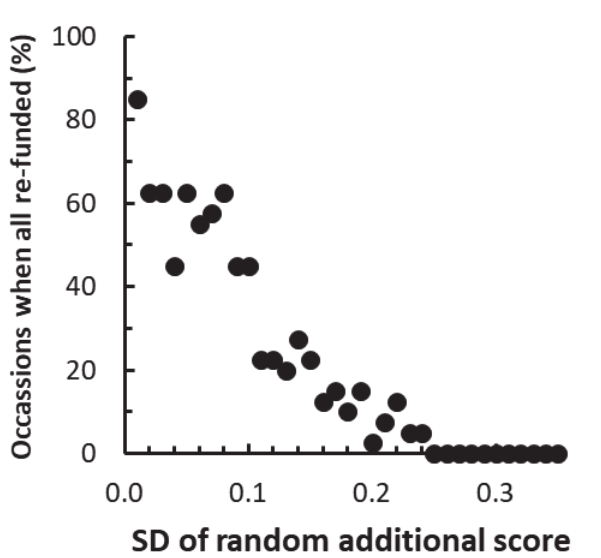
Figure 1. Results of adding a small random number to funding application scores for Panel 8 of the anonymous United Kingdom funding data: percentage (%) of 40 simulations that resulted in all previ- ously funded applications being awarded